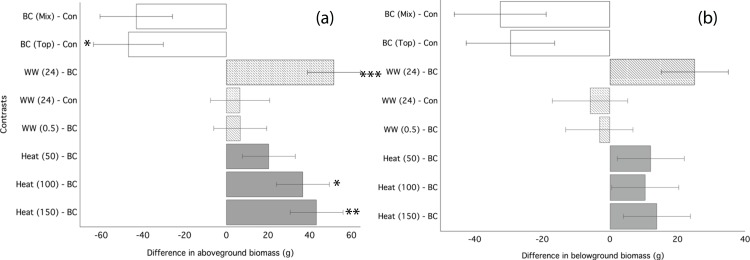
Ryegrass growth responses to thermally treated and leached chars: contrasts between treatments.Simultaneous confidence intervals (95%) for ryegrass aboveground biomass (A) and belowground biomass (B) responses to water washed (striped bars) and convection heated (grey bars) biochar (Experiment 2). BC, biochar (unwashed); BC (Mix), biochar, mixed; BC (Top), biochar, top-dressing. Abbreviations for heating (Heat) and washing (WW) treatments are defined in the methods. Significant differences between treatment means are denoted with asterisks (P = < 0.05*, < 0.01**, 0.001***).